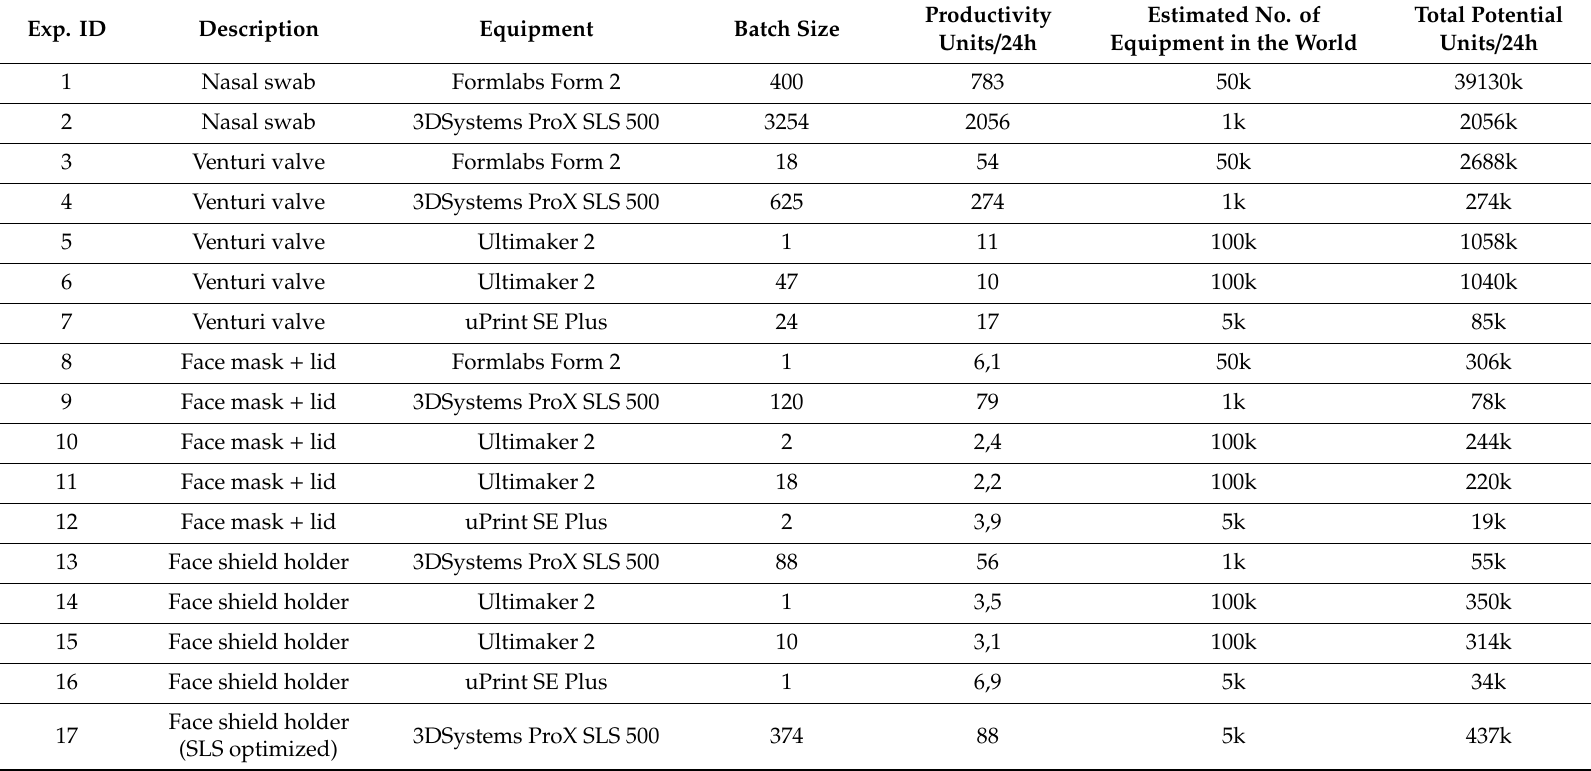
Table 6. The potential productivity of using 3D